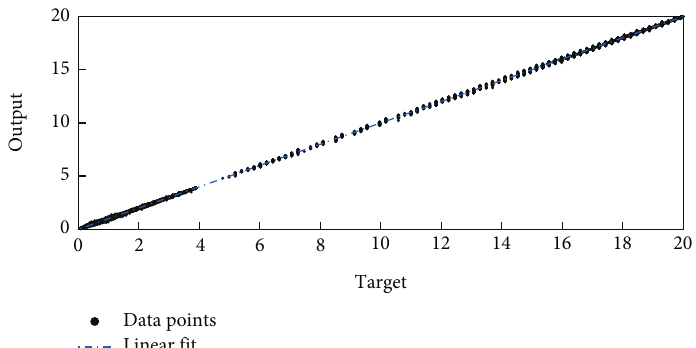
Figure 9: Regression plot of the ANN model for all the datasets (training, validation, and testing): regression coefficient = 0 : 99995 and mean square error ð MSE Þ = 0 : 0057967 .